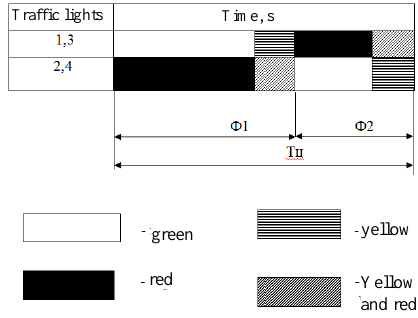
Fig 3. Typical diagram of 2-phase traffic lights cycle